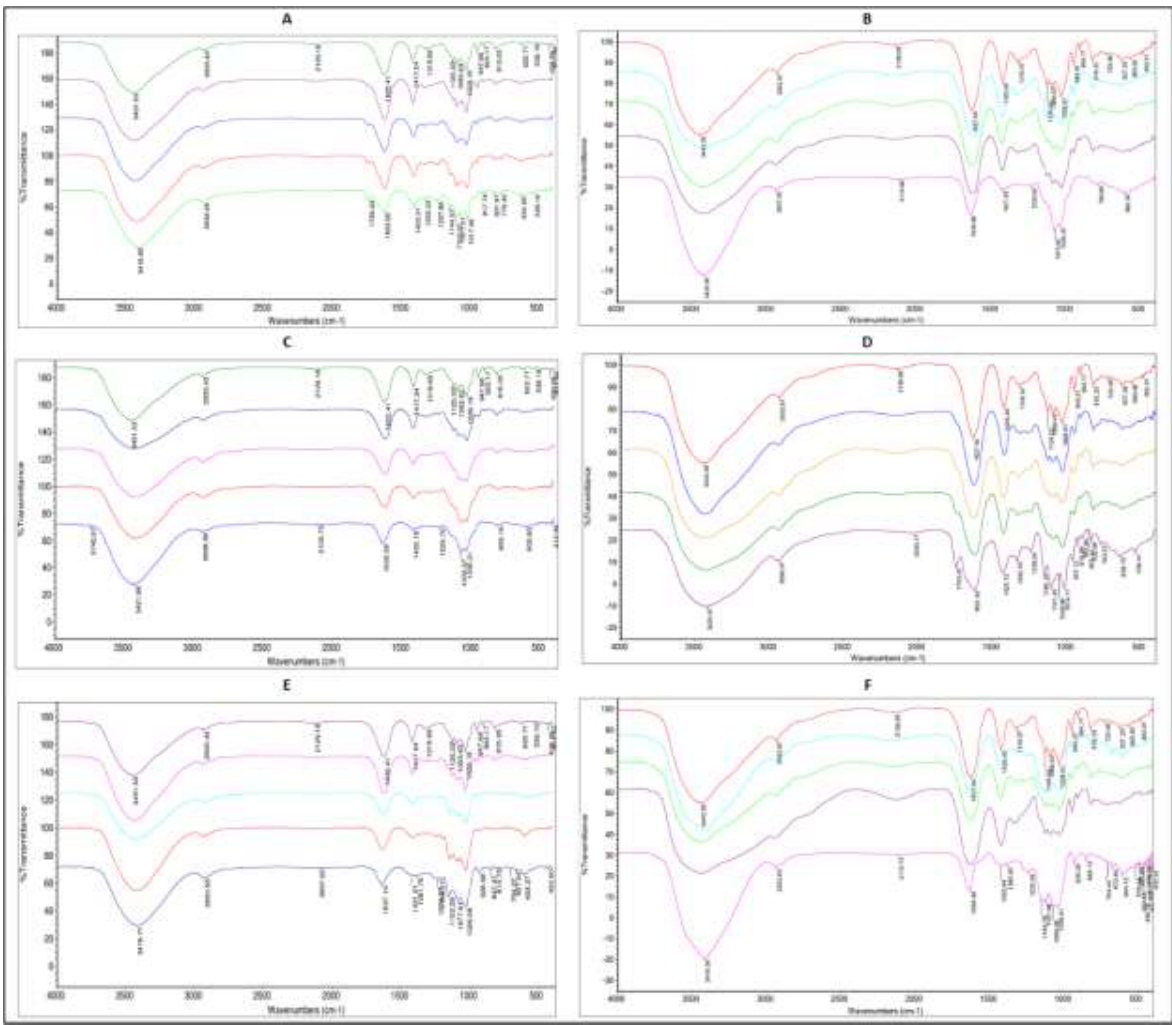
Figure 8. FT-IR spectra in CaCl 2 solution (a) alginate with gum acacia (c) alginate with pectin (e) alginate with carrageenan, in absence CaCl 2 (b) alginate with gum acacia (d) alginate with pectin (f) alginate with